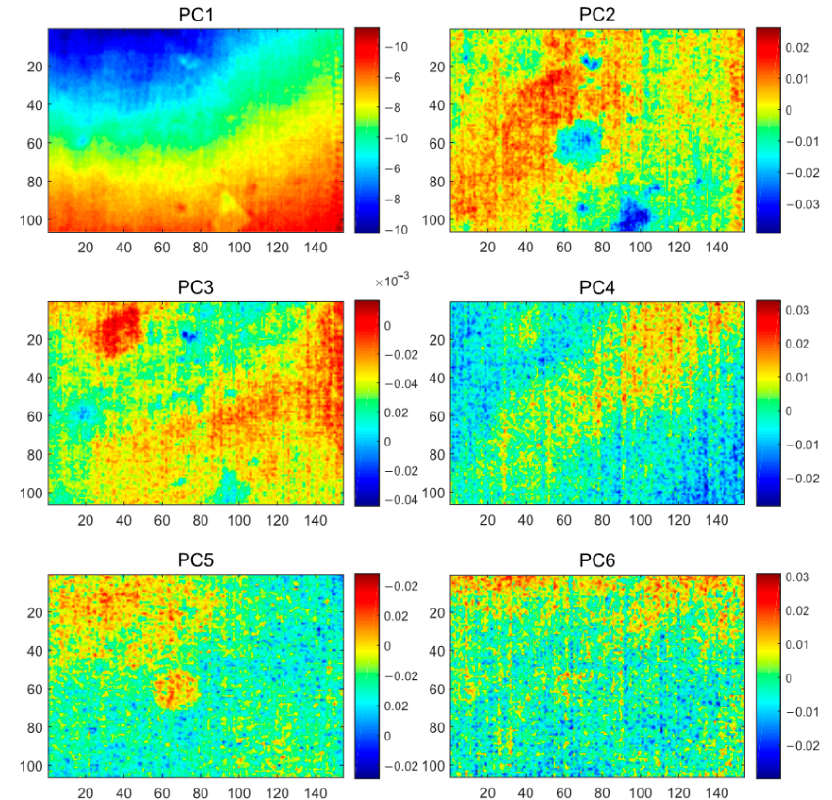
Figure 7. The PCT analysis results of the CFRP specimen 1.